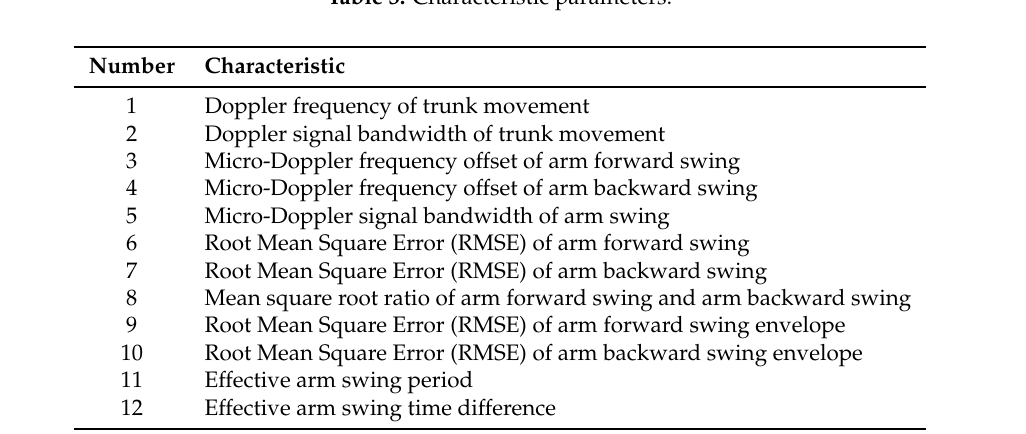
Table 3. Characteristic